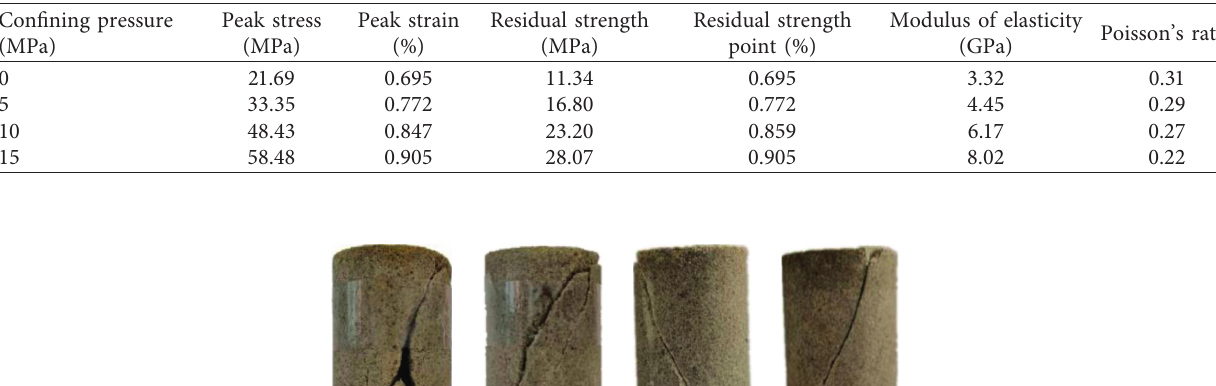
Table 1: Mechanical parameters of weak cementation sandstone.